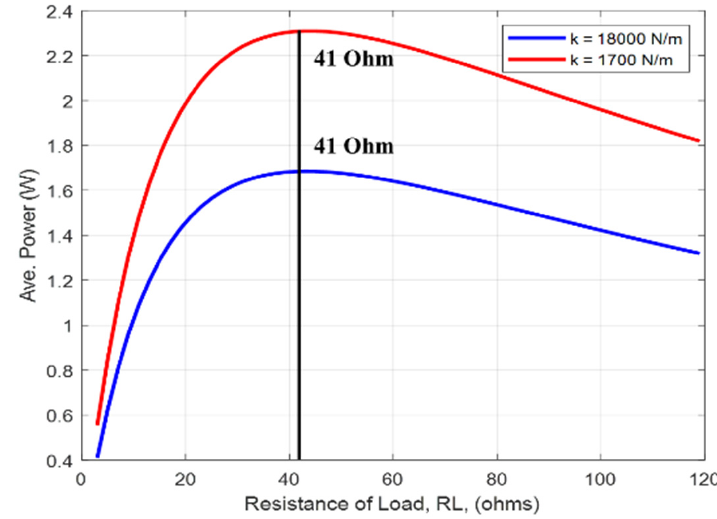
Figure 8. Averaged power when the load resistance is varied.